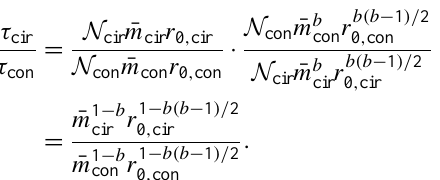
Fig. 2. Aggregation time scale for the removal of contrail ice crys- tals by sedimenting cirrus ice crystals as a function of the mean cir- rus crystal radius ¯ R cir and the cirrus crystal number concentration N cir . Note that only parameter combinations below the the main di- agonal can be considered realistic in cirrus clouds; thus aggregation timescales are typically of the order hours.